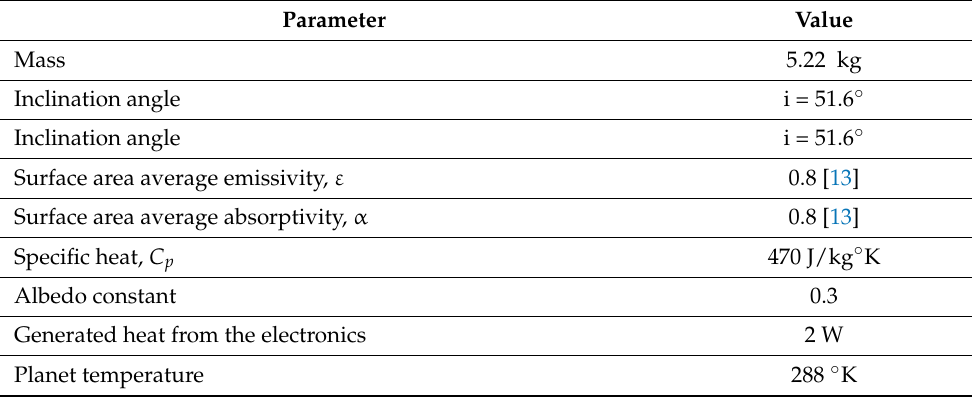
Figure 17. Modal analysis results: ( a ) deformation of the first mode and ( b ) deformation of the second mode. Table 14. Light-1 thermal analysis